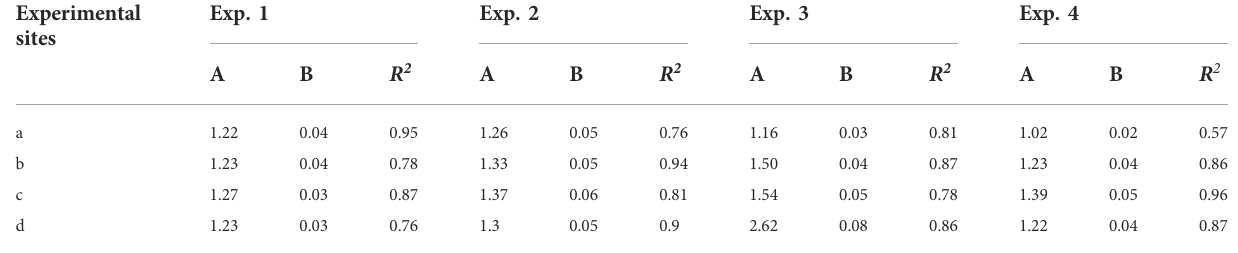
TABLE 3 Fitting coef fi cients and signi fi cance of root length density function. Experimental